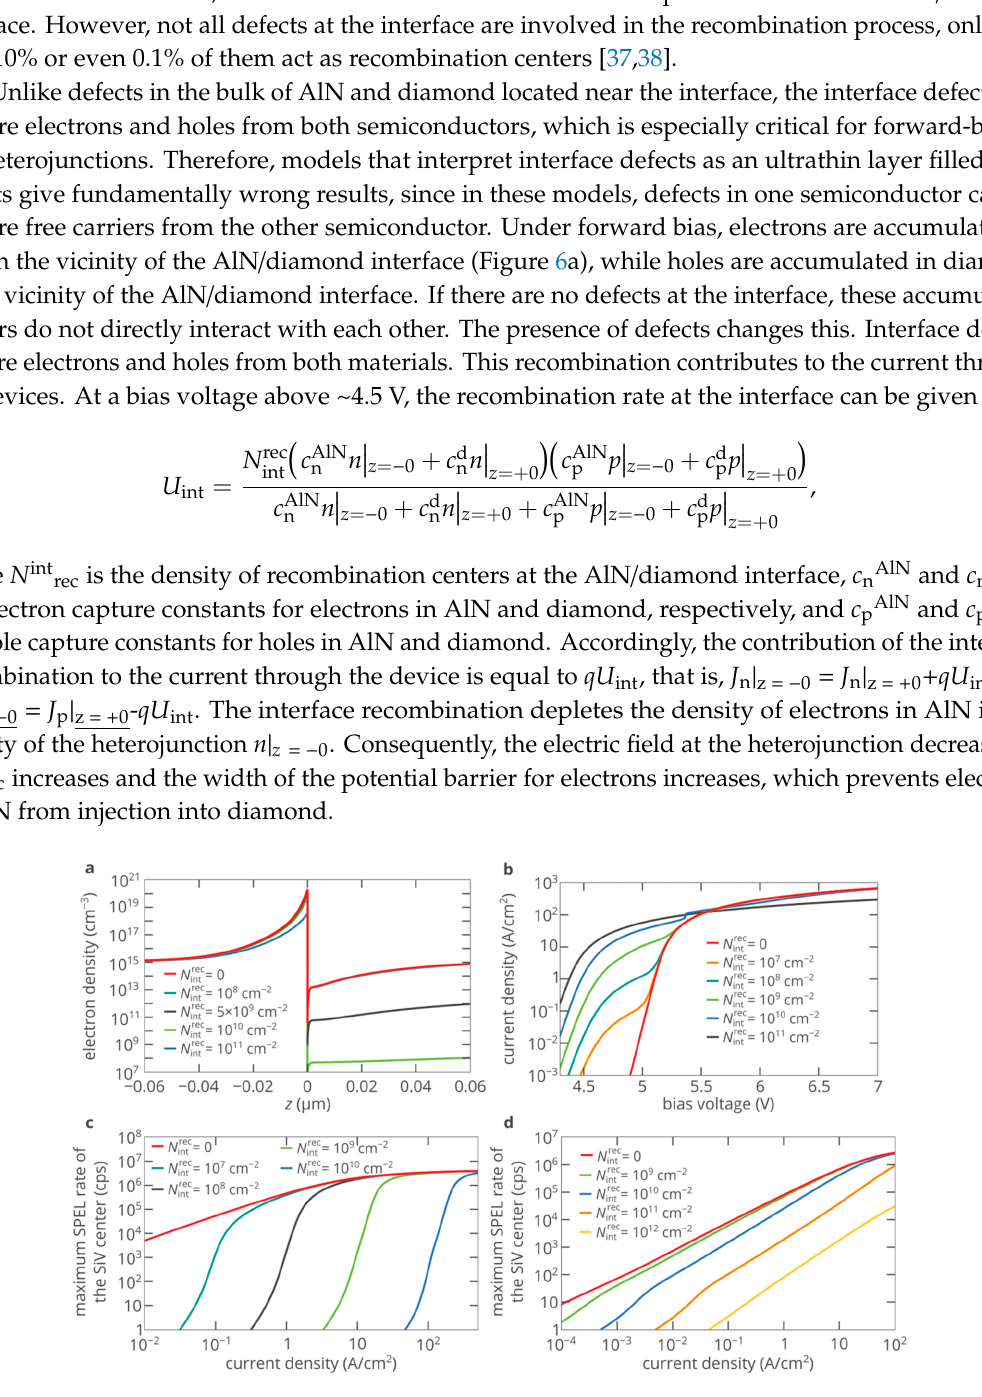
Figure 6. ( a ) Electron density distribution in the vicinity of the AlN / diamond heterojunction at a bias voltage of 5.3 V for di ff erent densities of recombination centers at the AlN / diamond interface. The CBO at interface is equal to 0.9 eV. ( b ) Current-voltage characteristic of the SPED for di ff erent densities of recombination centers at AlN / diamond interface. The CBO is 0.9 eV. ( c , d ) Dependence of the maximum SPEL rate of the SiV center in the i-type region of the AlN / diamond SPED on the pump current density for di ff erent densities of recombination centers at the AlN / diamond interface at a CBO of 0.9 eV (panel c) and 0.4 eV (panel